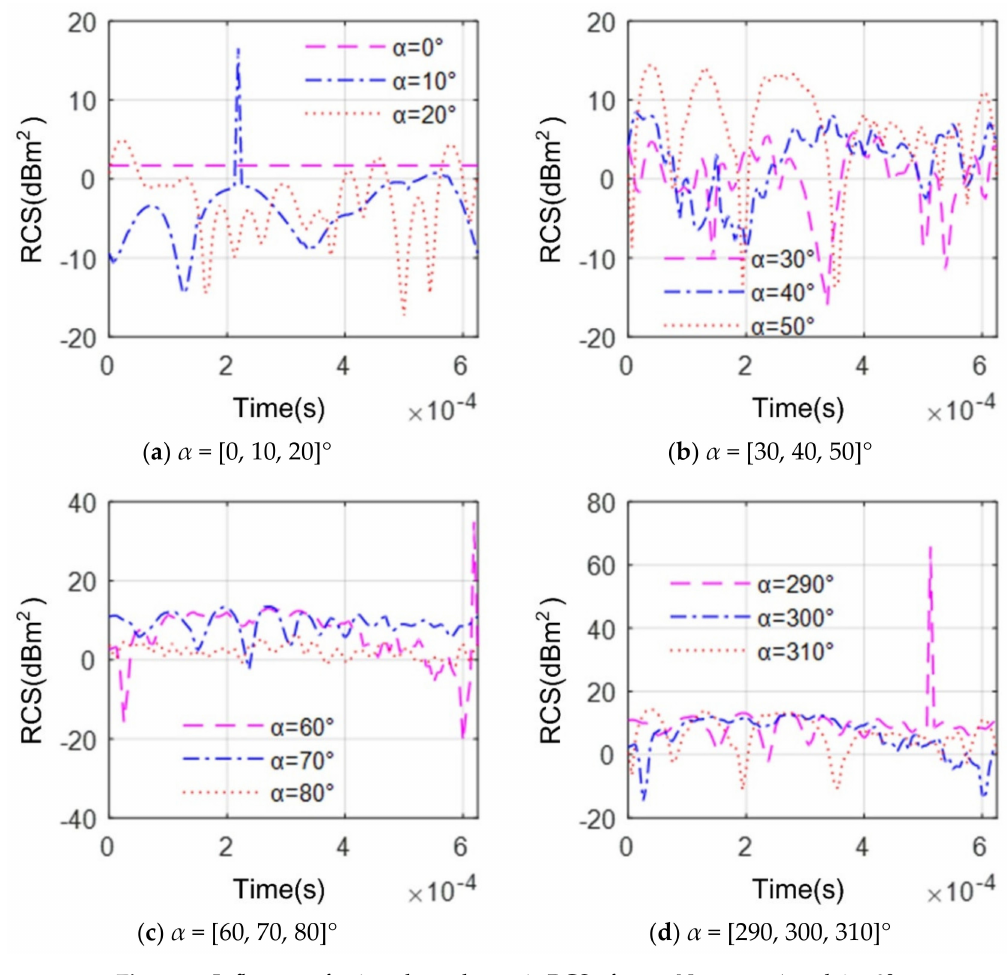
Figure 9. Influence of azimuth on dynamic RCS of m fan , N obs,fan = 1 and β = 0 ◦ .